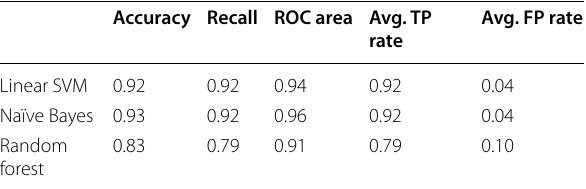
ROC receiver operating characteristic, SVM support vector machines, TP true positive, FP false positive